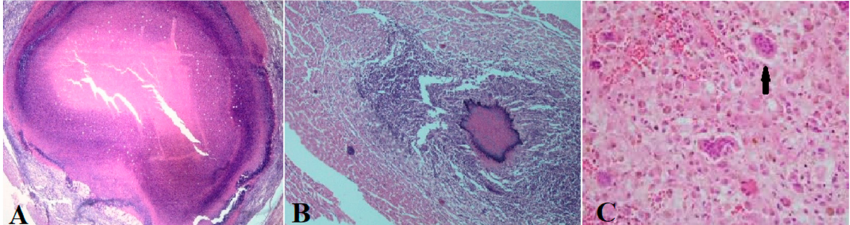
Figure 2. Caseous necrosis ( A ; H and E, 40x), granulomas ( B ; H and E, 10x), multinucleated giant cell ( C ; H and E, 1000x) in the cardiac muscle infected with Taenia ovis (A), and accumulation of mononuclear inflammatory cells and the formation of fibrous tissue around (H and E,